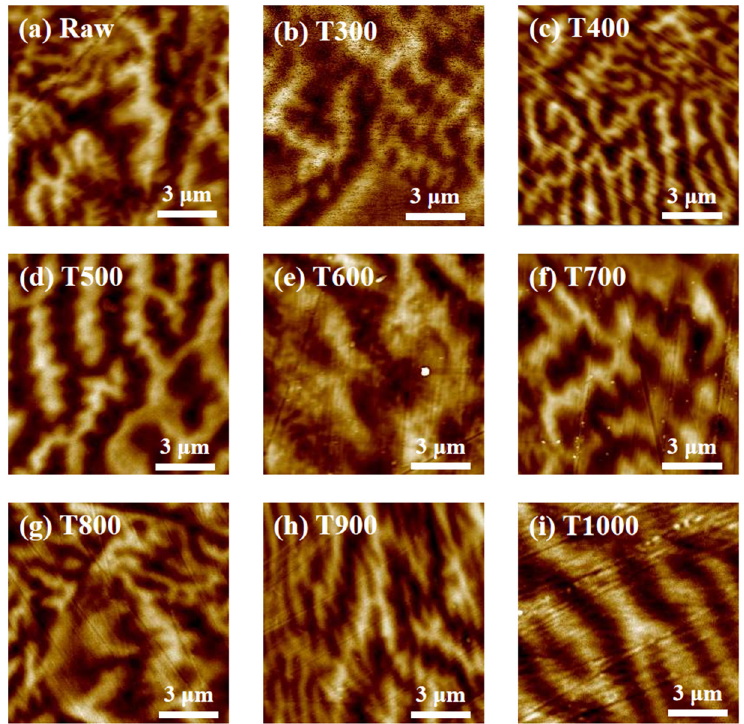
Figure 3. Magnetic domain images of raw ( a ), T300 ( b ), T400 ( c ), T500 ( d ), T600 ( e ), T700 ( f ), T800 ( g ), T900 ( h ), and T1000 ( i ), at room